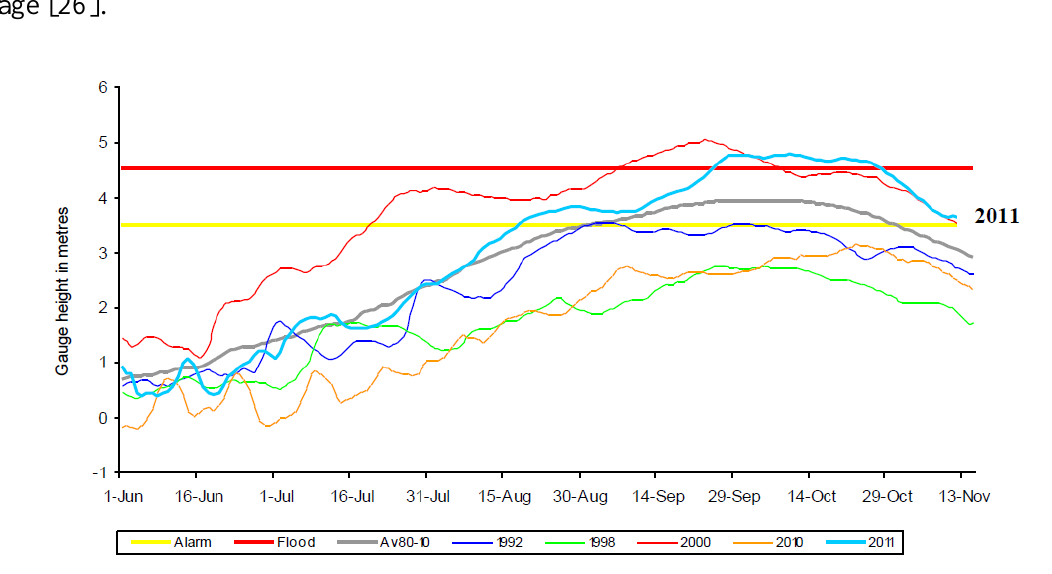
Figure 7. Mekong River flooding at Tan Chua gauge from 1 June through 11